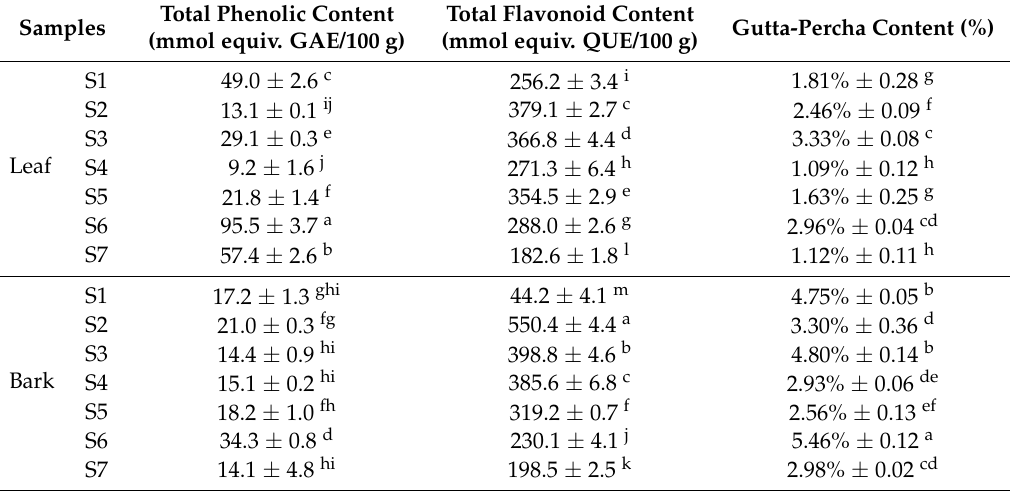
Table 1. Contents of total phenolic, total flavonoids, and gutta-percha of leaf and bark of different E. ulmoides